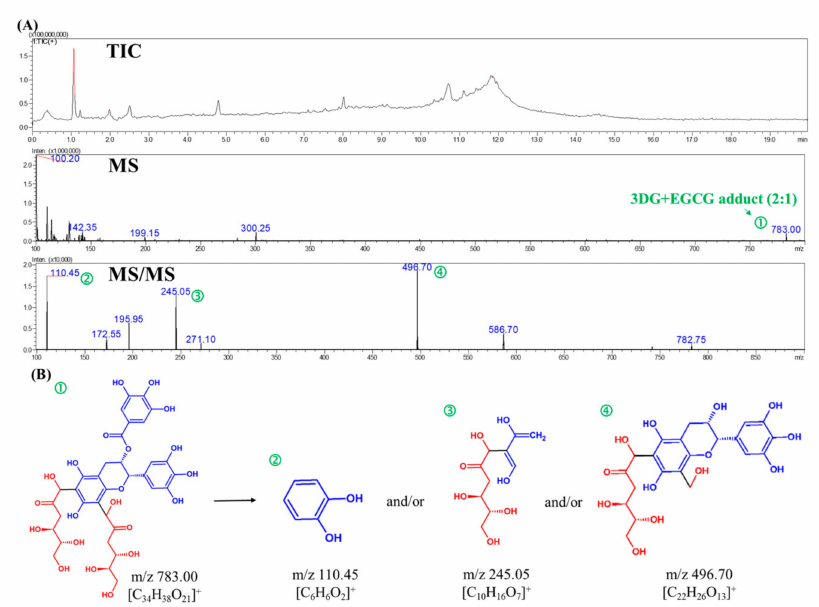
Figure 6. ( A ) Total ion chromatogram, MS spectra and MS/MS spectra of a molecule with an m / z of 783 for products generated from the reaction of EGCG and 3-DG at 70 ◦ C for 30 days. ( B ) Scheme of the fragmentation of the 3-DG–EGCG adducts observed in MS/MS analysis (EGCG: blue; 3-DG: red). TIC: total ion